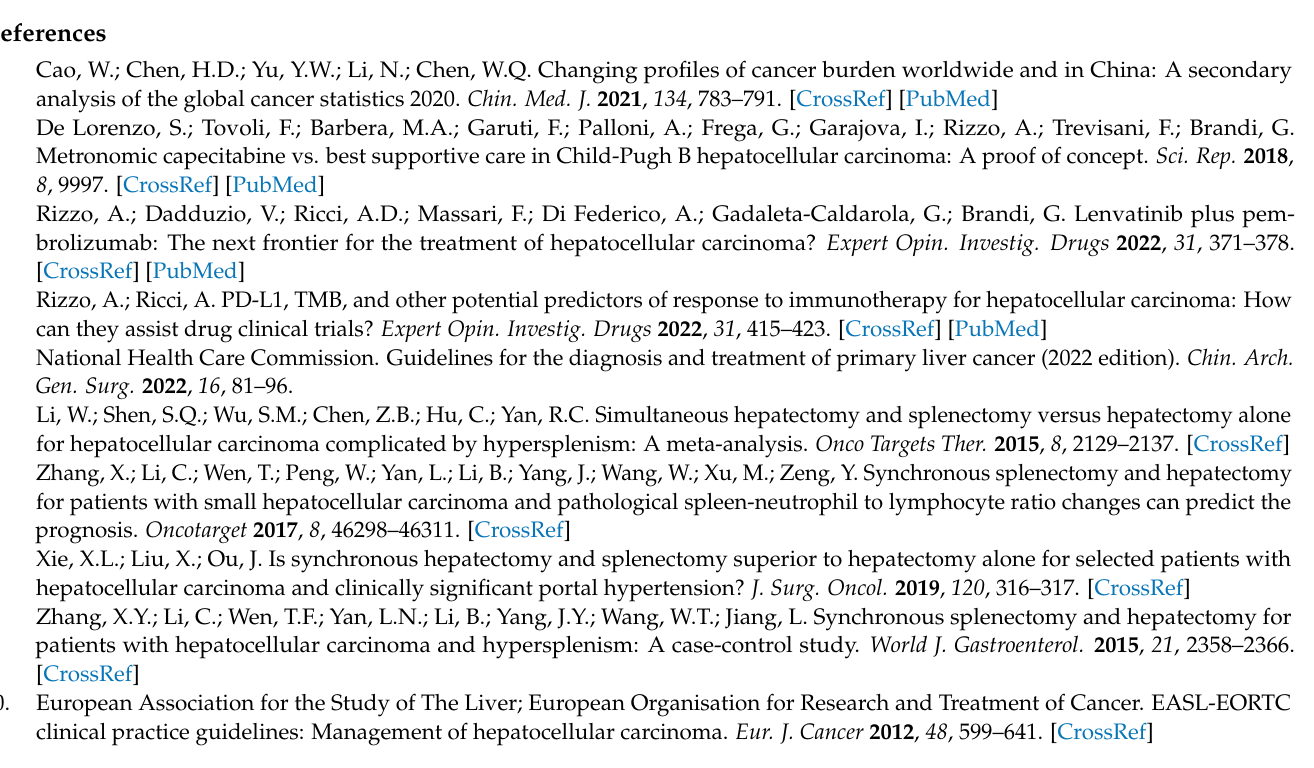
the HS group ( p = 0.000). Figure S2: Different CTP grade at 3-year OS in the HS group ( p = 0.002). Figure S3: Different CTP grade at 5-year OS in the HS group ( p = 0.009). Figure S4: Different CTP grade at 1-year RFS in the HS group ( p = 0.000). Figure S5: Different CTP grade at 2-year RFS in the HS group ( p = 0.001). Figure S6: Different CTP grade at 3-year RFS in the HS group ( p = 0.004). Figure S7: Different CTP grade at 5-year RFS in the HS group ( p =